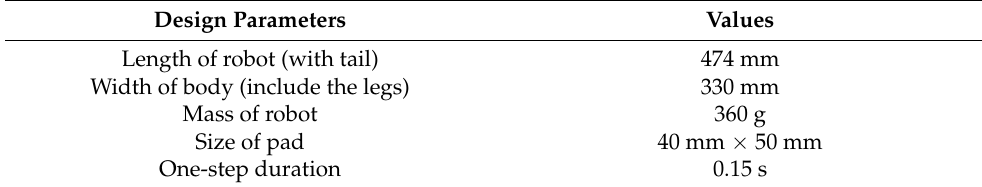
Table 2. The dimensions of the robot